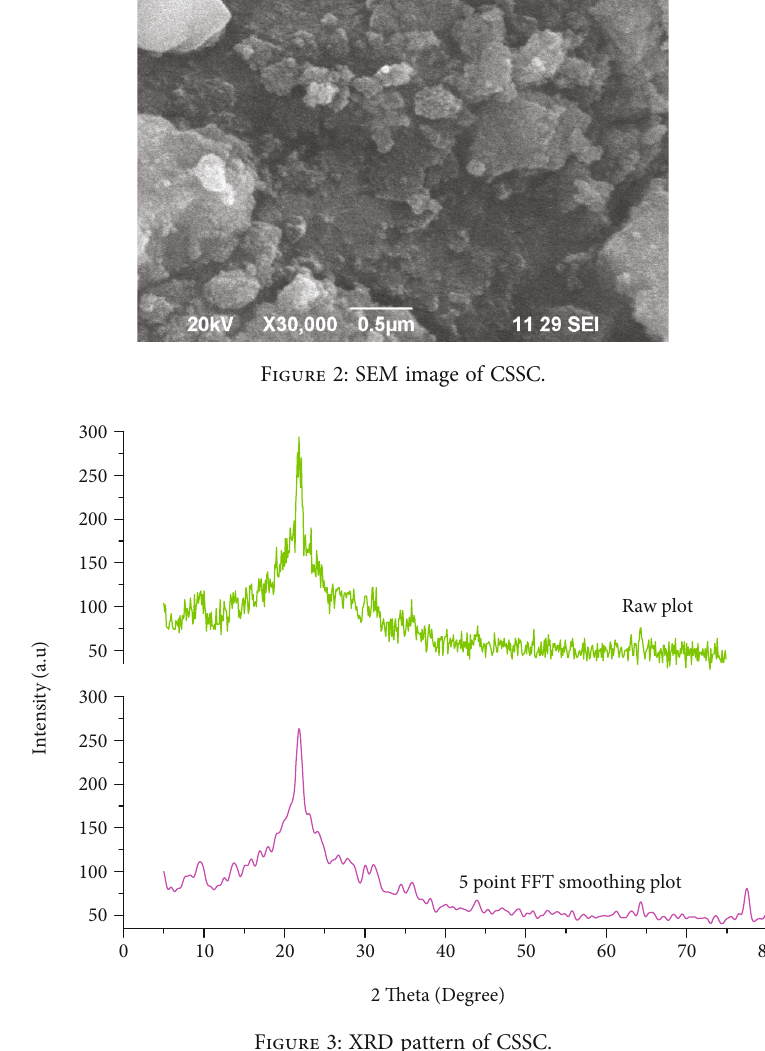
Figure 3: XRD pattern of